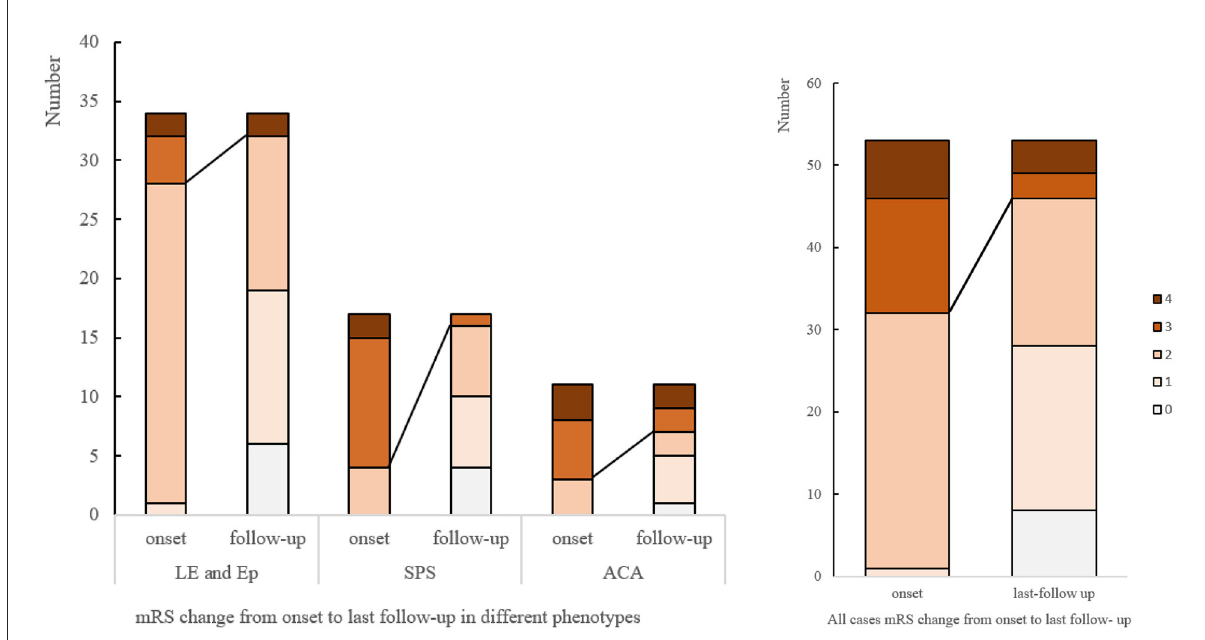
FIGURE3 mRS changes from onset to last follow-up. mRS, modified Rankin score; LE, limbic encephalitis; Ep, epilepsy; SPS, stiff person syndromes; ACA, autoimmune cerebellar ataxia.